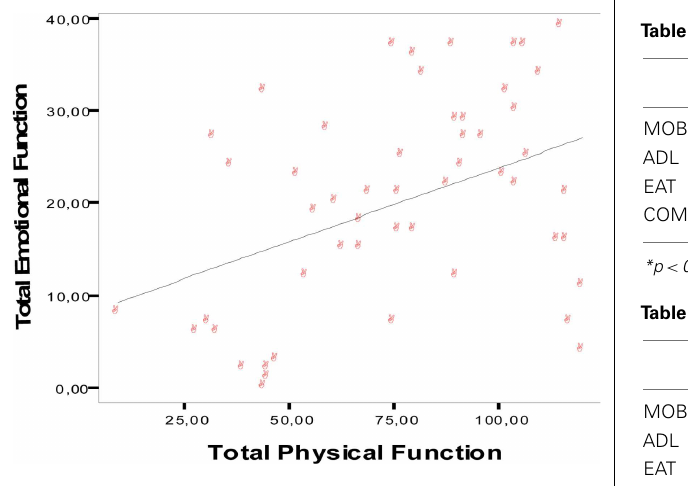
FIGURE 2 | Dispersion graph for emotional functioning and total combined physical functions at the third evaluation.